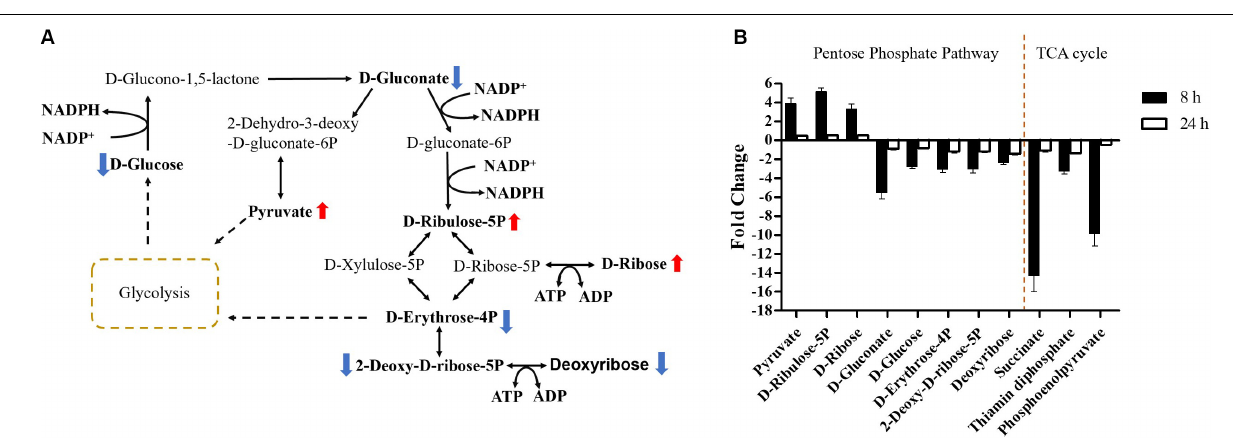
FIGURE 7 | Central metabolic changes in pentose phosphate pathway. (A) In the pathway flow charts (adapted from KEGG Pathway with reference to E. coli K-12), red arrows and blue arrows indicate that the metabolites were significantly increased or decreased, respectively. (B) Metabolites associated with this pathway and TCA cycles at 8 and 24 h. FDR < 0.05, p < 0.05 and fold change ≥